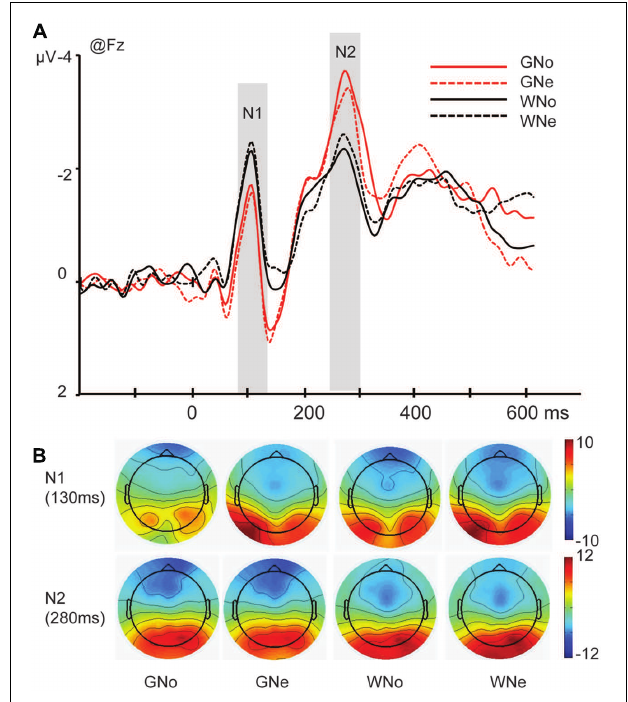
FIGURE 2 | (A) Grand average of N1 and N2 components at Fz site in the four conditions; (B) voltage scalp maps for N1 and N2 in four conditions